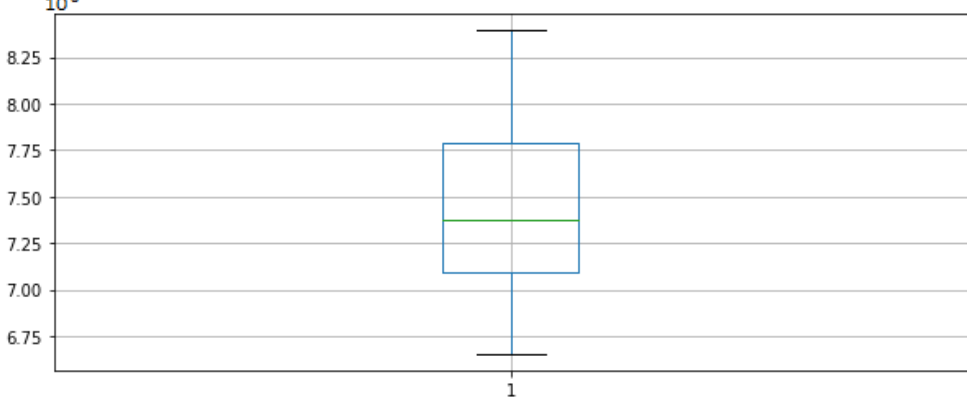
Figure 19. Boxplot of 10 runs on Belgium 2017